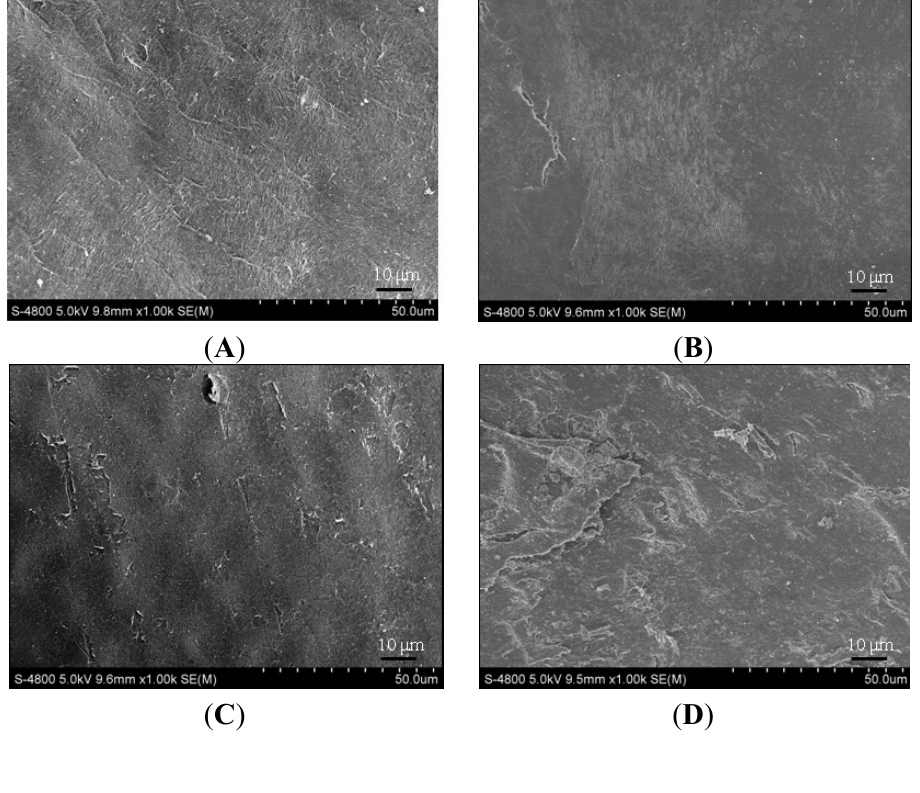
Figure 4. Findings of articular cartilage at proximal tibia under scanning